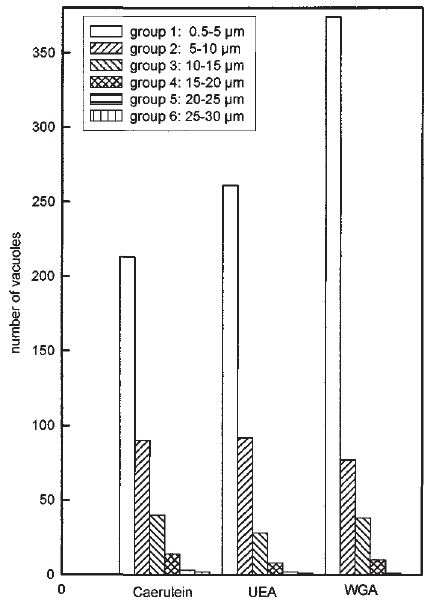
Fig. 6. Classification of the diameter of vacuoles inside pancreatic acinar cells after ip medication of cerulein with or without simultaneous lectin administration. WGA and UEA; increase of the number of smallest vacuoles (white column), presumably endocytic vesicles (group 1, 0.5–5 (cid:22) m) under lectin administration, whereas both lectins diminished the number of largest injury vacuoles (group 5, 20–25 (cid:22) m; group 6, 25–30 (cid:22)